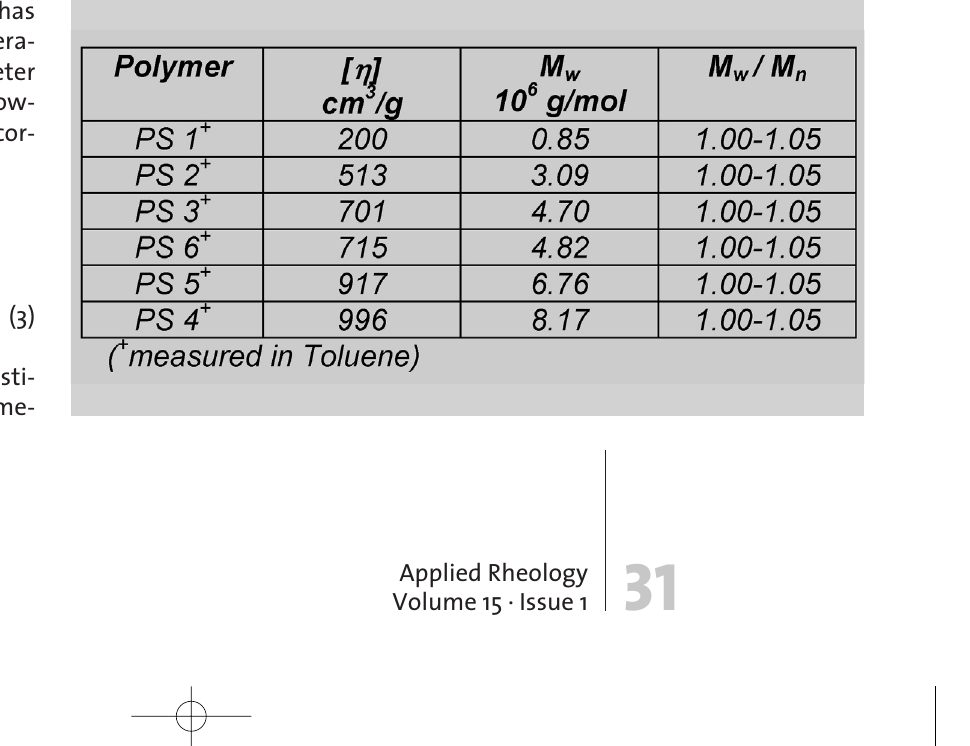
Table 3: Molecular para- meters of the investigated polystyrene